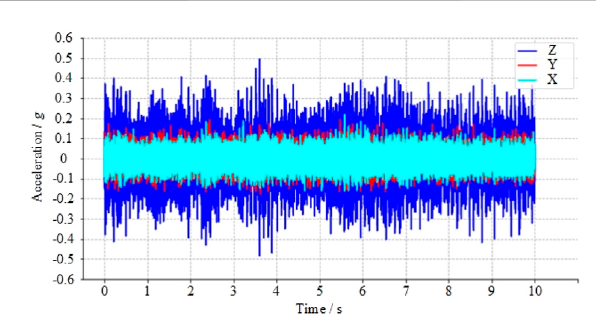
FIGURE 8 Vibration signals under minor cavitation condition.